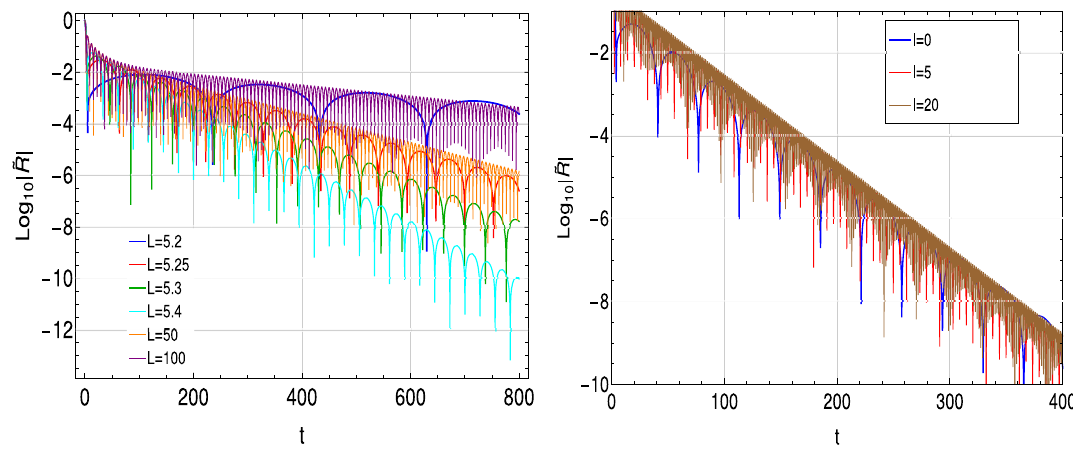
Fig. 1 Time evolution of the scalar field with different values of (cid:2) and L . The parameters of the geometry are M = m / 0 . 3 = η = 1 and L / 6 = 1 (right) (cid:2) = 0 (left) Table 1 Fundamental quasinormal modes for non-minimally coupled scalar field evolving in Schwarzschild–dS black